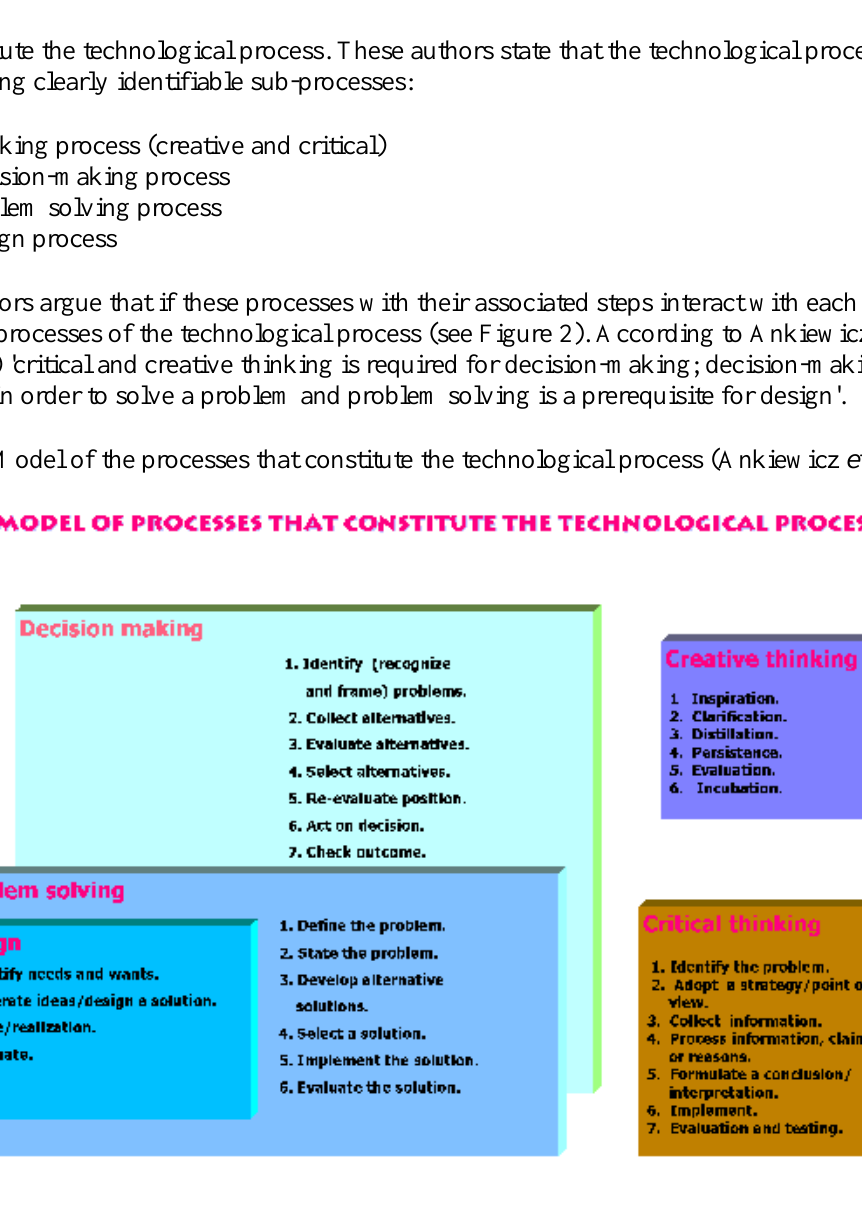
Figure 3 Model of thinking (Marzano, et al. , 1988; referred to by Johnson,